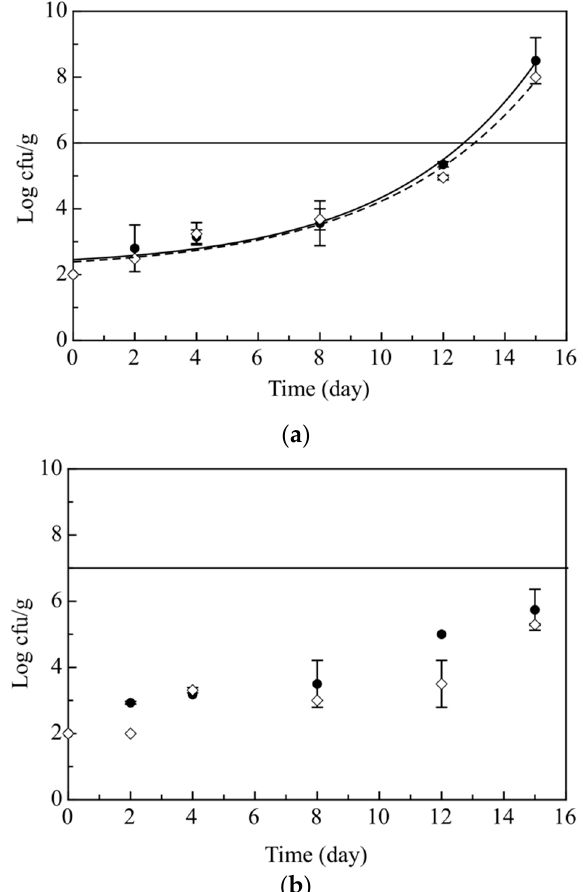
Figure 3. Evolution during 15 days of storage at 4 ◦ C of Shewanella ( a ) and Photobactherium ( b ) in the breaded cod sticks. The curves are the best fitting of the experimental data. ( • ) Control breaded cod sticks without olive paste (Ctrl) ( ♦ ) Active breaded cod sticks with olive paste